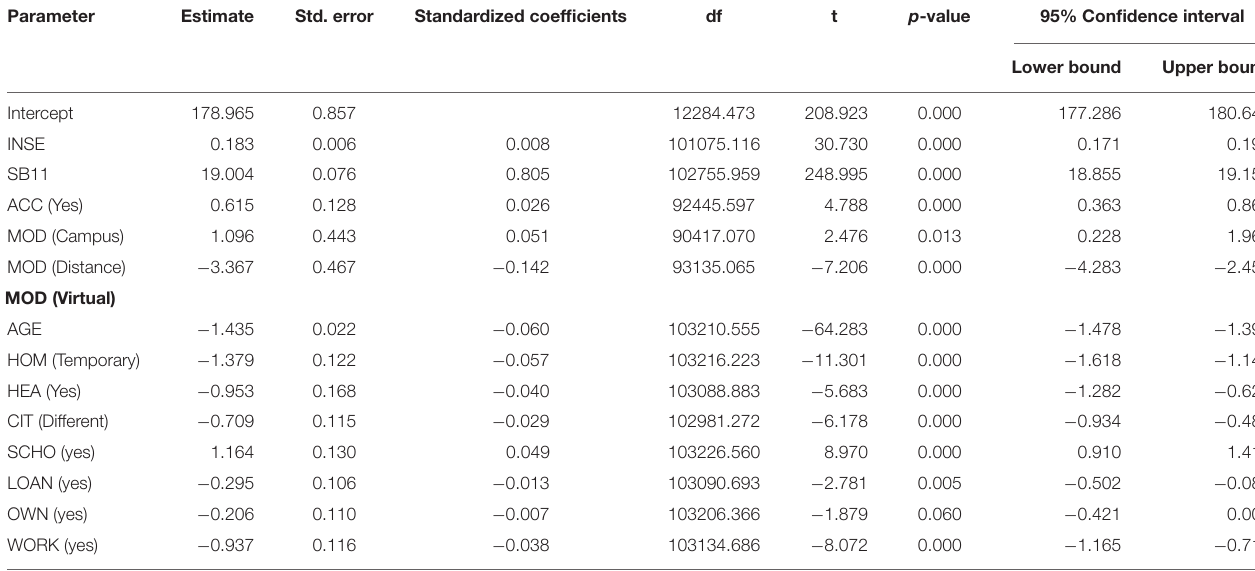
TABLE 4 | Estimate of the model. Parameter